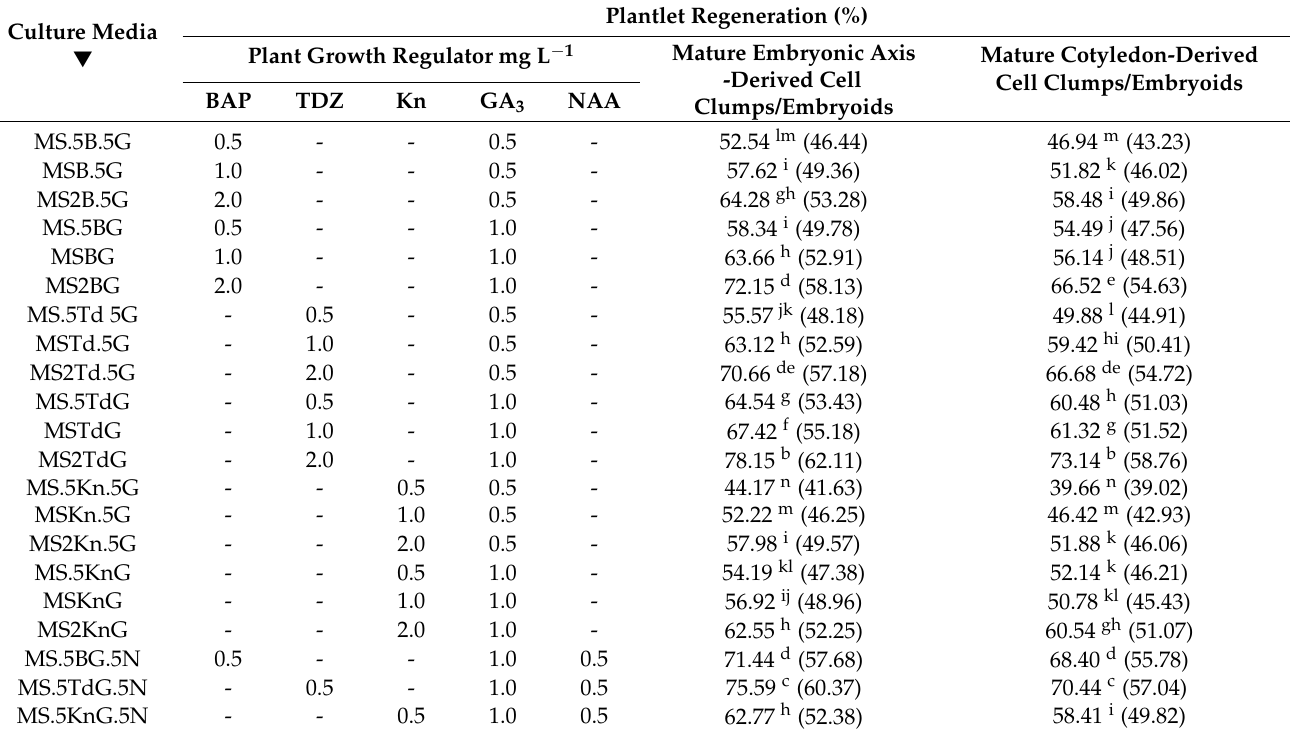
Table 4. Combined influence of different plant growth regulators at variable concentrations and combinations on regenera- tion on plantlets from embryoids/cell clumps raised from embryogenic suspension cultures. Culture Media